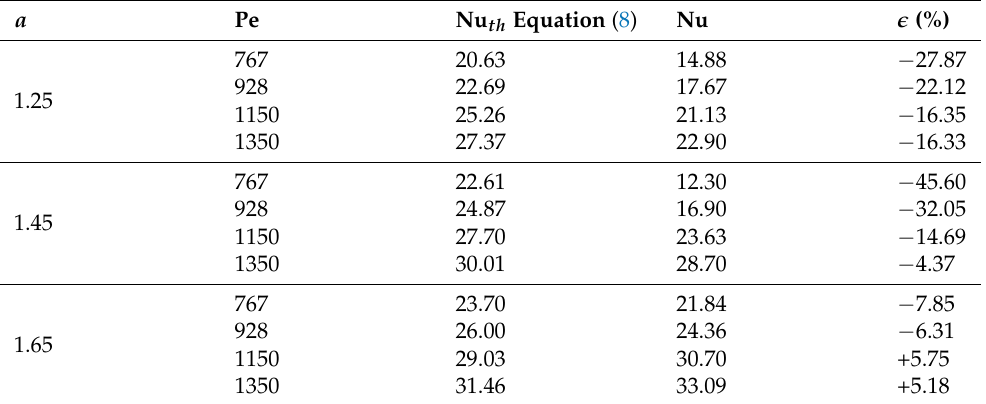
Table 5. Comparison between the bundle-averaged Nu, calculated with Equation (9), and reference values estimated with Equation (8) for the in-line bundle. Relative deviation (cid:101) = ( Nu − Nu th ) / Nu th . a